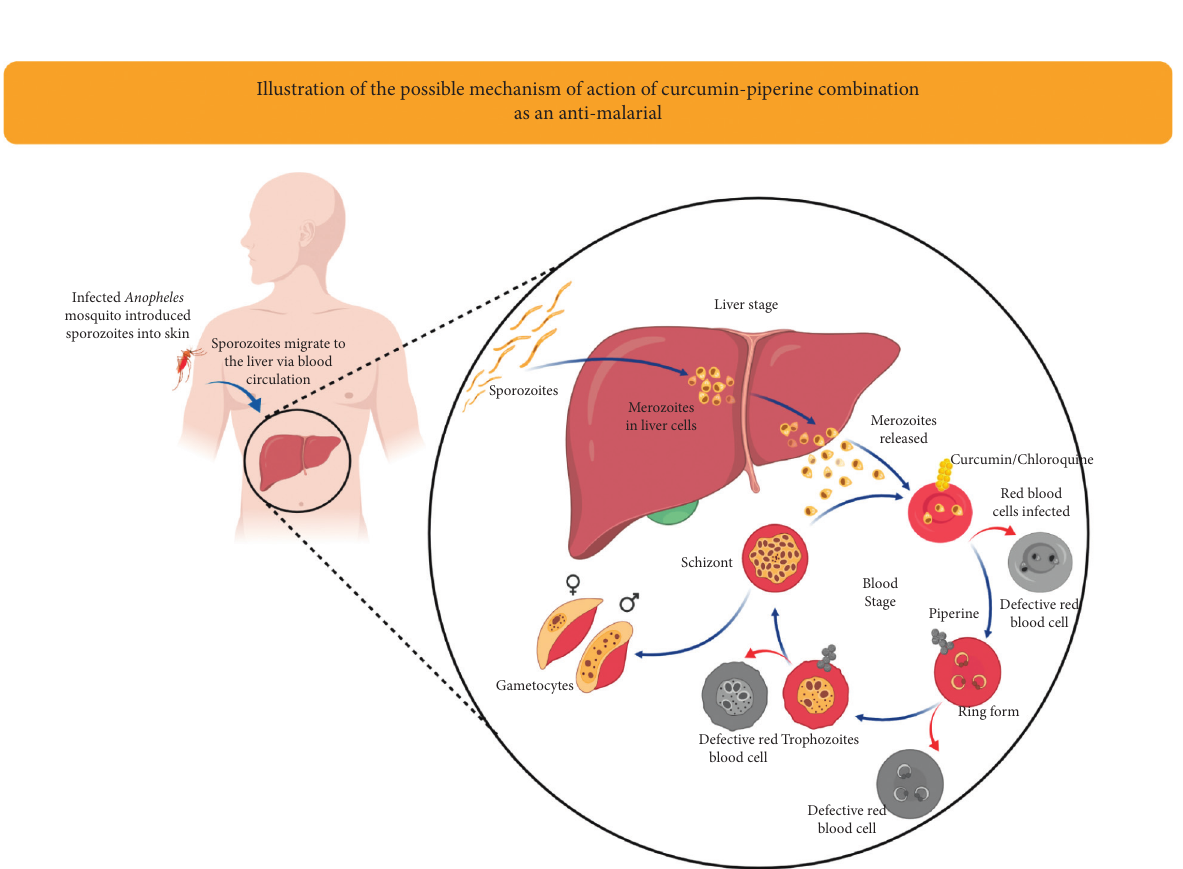
Figure 2: Illustration of the possible mechanism of action of curcumin-piperine combination as an antimalarial. Infected Anopheles mosquito introduced sporozoites into skin. Sporozoites migrate to liver via blood circulation and initiate the liver stage. At the liver stage, sporozoites invade the hepatocyte and undergo further development into merozoites. At the blood-stage, merozoites infect RBCs and start degrading hemoglobin (Hb). Heme released is polymerized to curtail its toxicity on the parasite. For example, chloroquine (medication primarily used to prevent and treat malaria) kills the parasites by blocks heme polymerization. Curcumin, probably having a similar action with chloroquine, restricts parasite development at the early stage. Meanwhile, piperine can make morphological changes (cytoplasm condenses) at the late ring to trophozoites stages, thus becoming defective red blood cells. Piperine as a bioenhancer may potentiate the effects of curcumin. Hence, combining curcumin and piperine as an antimalarial is expected to act at an earlier stage of the blood